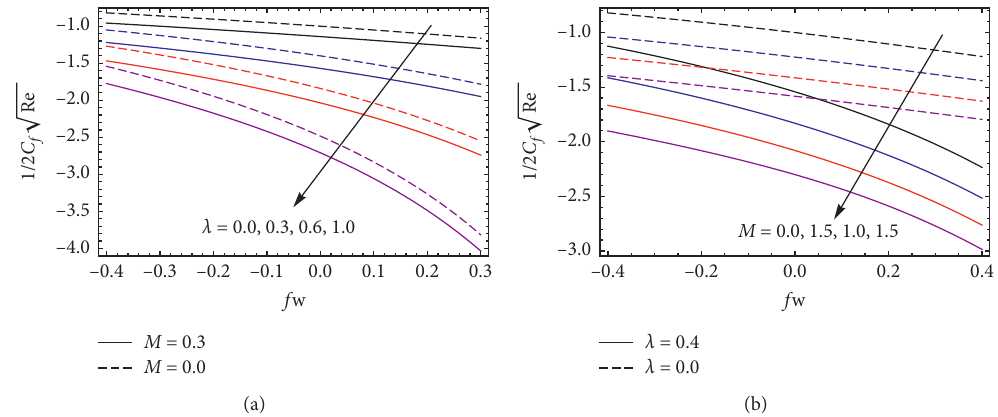
Figure 6: Impact of skin friction on combined parameters. (a) λ and fw and (b) M and fw